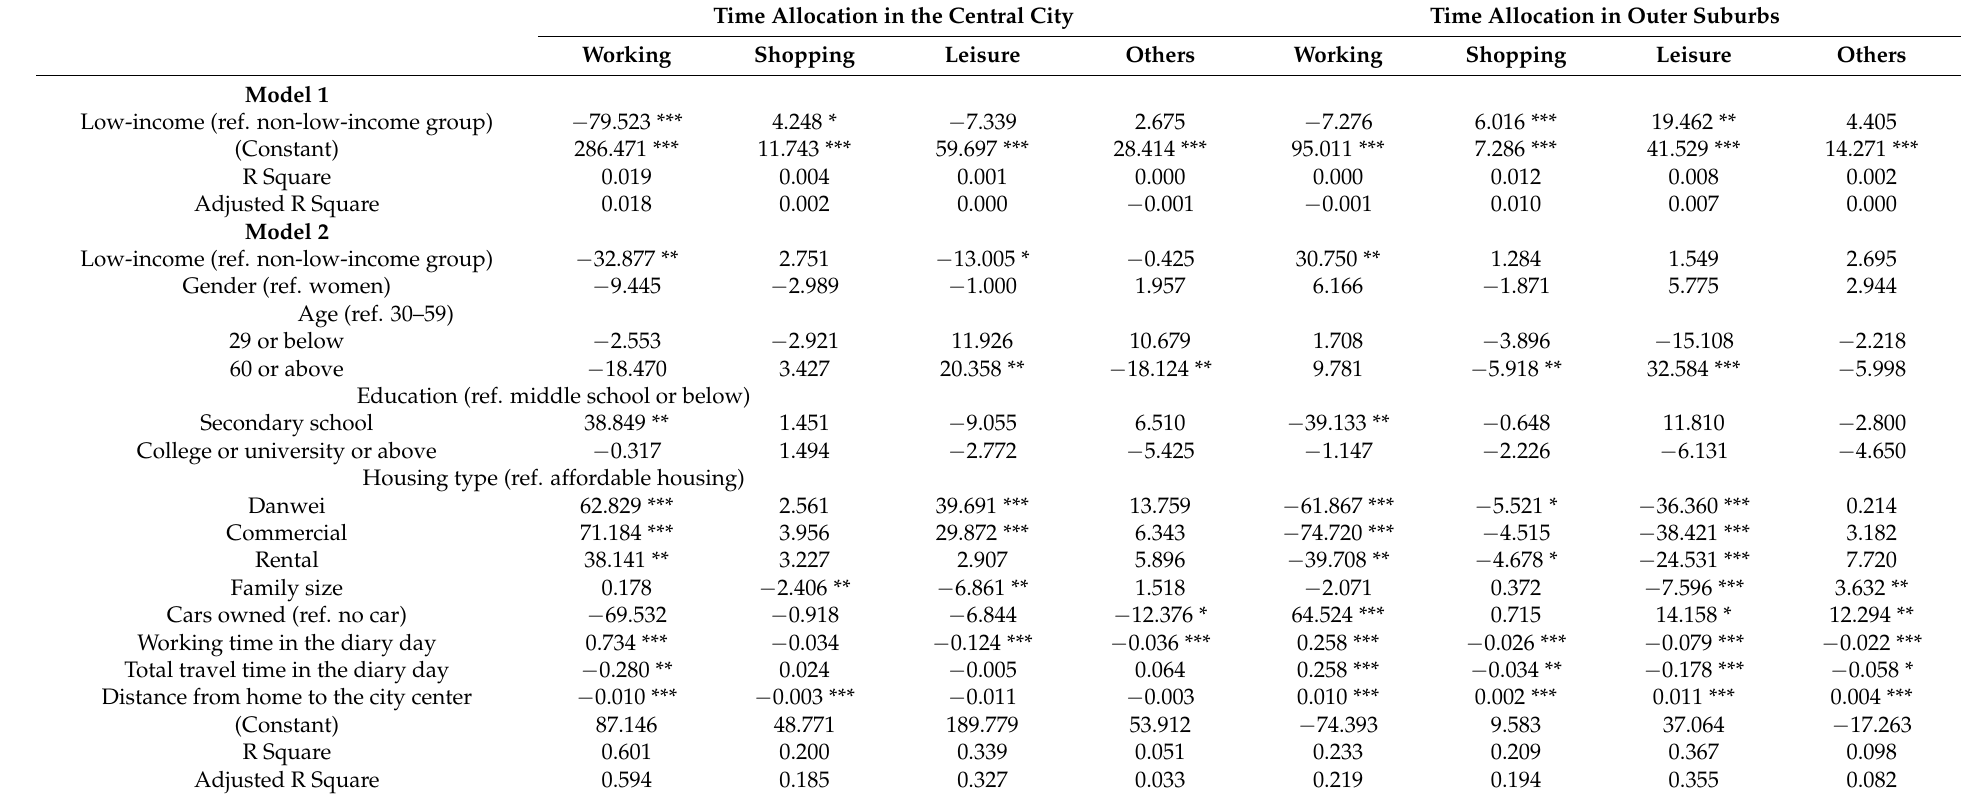
Table 7. Factors affecting the spatial distribution of individual activity time on weekdays. Time Allocation in the Central